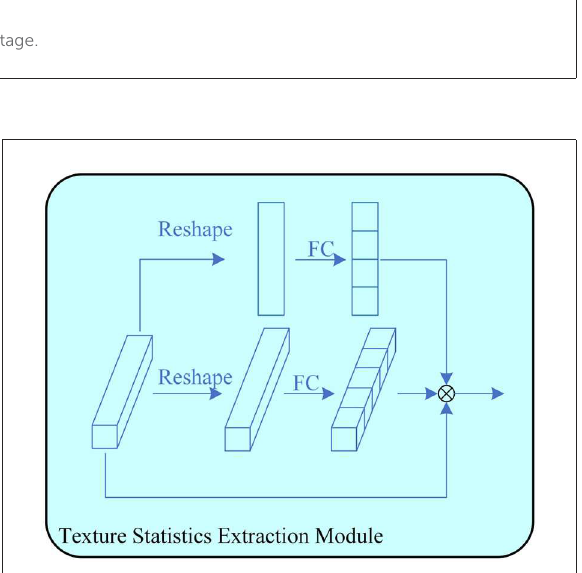
FIGURE3 The proposed Texture Statistics Extraction Module. It is used to extract statistics at different